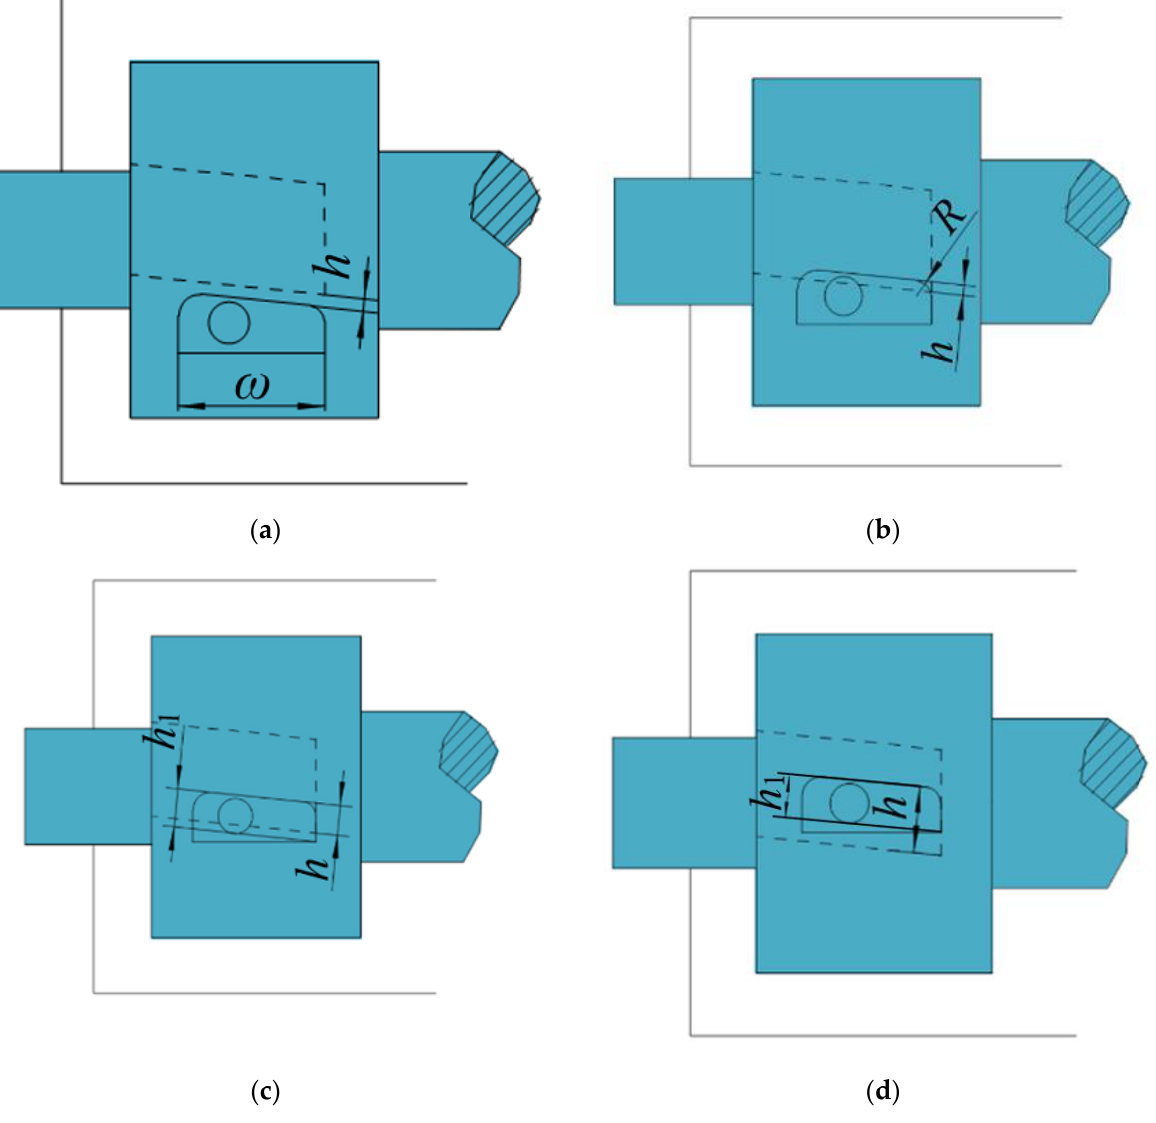
Figure 3. Change in overlap area between high- and low-pressure holes and chute: ( a ) h ≤ 0; ( b ) 0 < h ≤ R ; ( c ) R < h ≤ h 1 ; ( d ) h 1 < h .